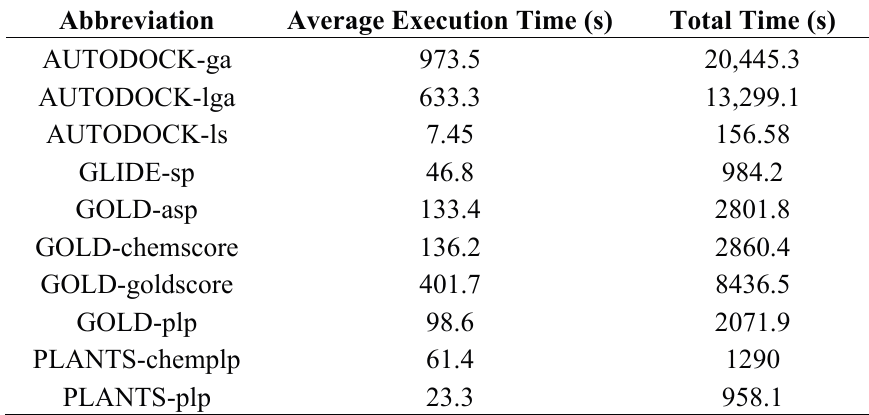
Figure 3. Results of the docking benchmark study on human checkpoint kinase 1. ( A ) Minimum RMSD values (RMSD min ) returned by the tested docking protocol (y-values) for the considered X-ray structures (x-values); ( B ) Average RMSD values (RMSD ave ); ( C ) Numbers of conformations returned by each docking protocol having a RMSD value lower than the X-ray structure resolution (N (RSMD < R) ); ( D ) Protocol Score. RMSD is expressed in Å, whereas the Protocol Score on a 0–3 points scale. Values are rendered with a colour code, blue spots identify the best obtained results. Exclamation marks warn that an error occurred during docking calculations. Table 2. Protocol performances for the hChk1 case study (20 proteins, 17 protocols). Time is expressed in seconds. Calculations were performed on a HP server equipped with four AMD Opteron6282